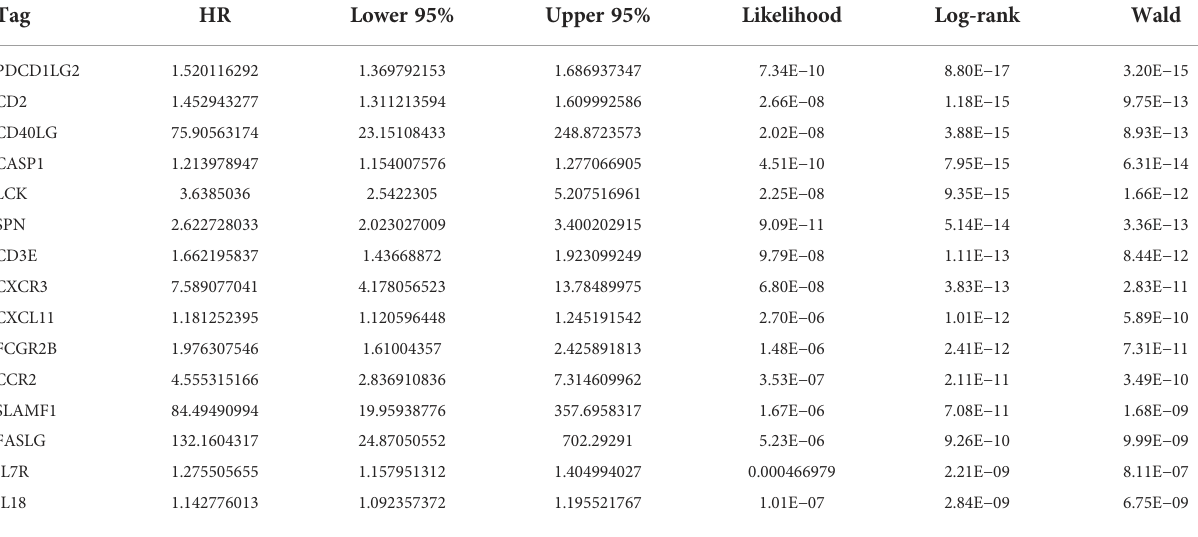
TABLE 2 Univariate Cox regression